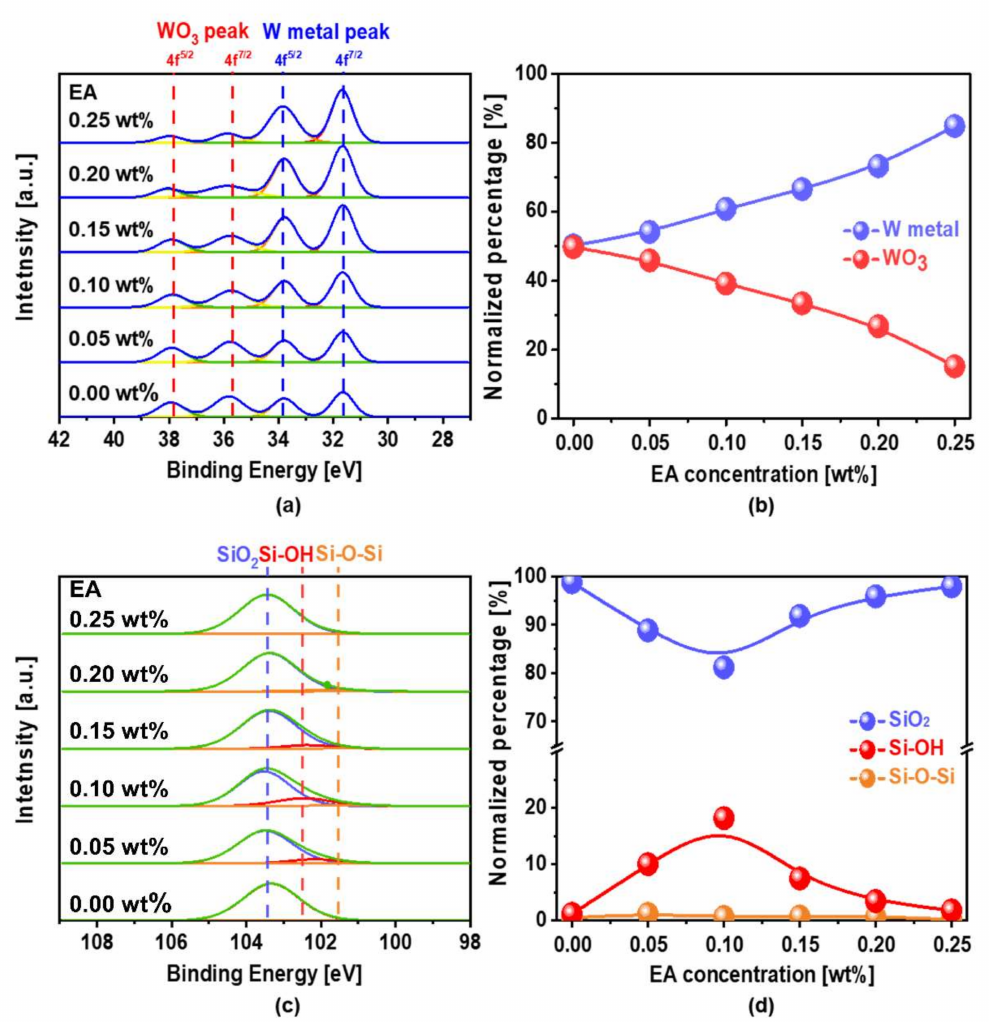
Figure 6. Chemical composition of W- and SiO 2 -film surfaces depending on the scavenger (i.e., EA) concentration and analyzed by XPS after the W-film surface CMP, depending on the scavenger (i.e., EA) concentration, ( a ) Spectra XPS intensity vs. binding energy of WO 3 and W-metal on the W-film surface; ( b ) normalized XPS peak percentage of WO 3 and W-metal on the W-film surface; ( c ) spectra intensity vs. binding energy of Si–O–Si, SiO 2 , and Si–OH on the SiO 2 -film surface, and ( d ) normalized XPS peak percentage of Si–O–Si, SiO 2 , and Si–OH on the SiO 2 -film surface after CMP. 3.4. Dependency Mechanism of W- and SiO 2 -Film Surface Polishing Rates on